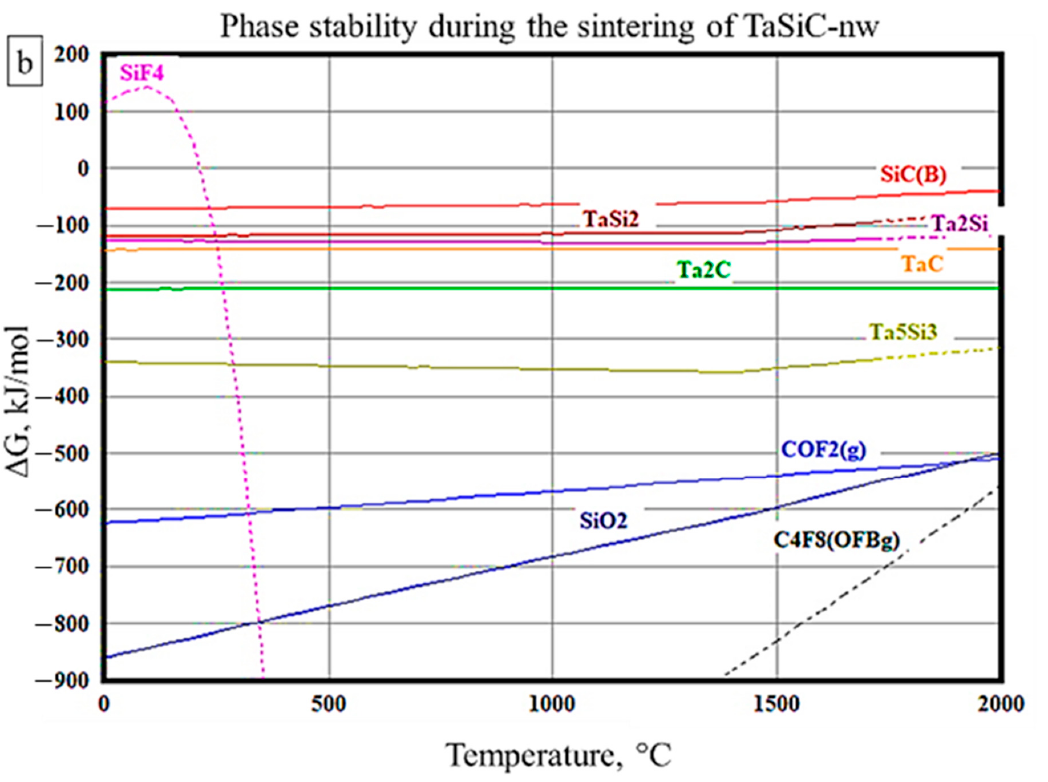
Figure 4. Ellingham diagrams of phase stability for selected gaseous species in the Ta-Si-C-O-F system ( a ) and sintering of TaSiC-nw composition ( b ). Solid lines correspond to experimentally measured values, dotted lines to projections.